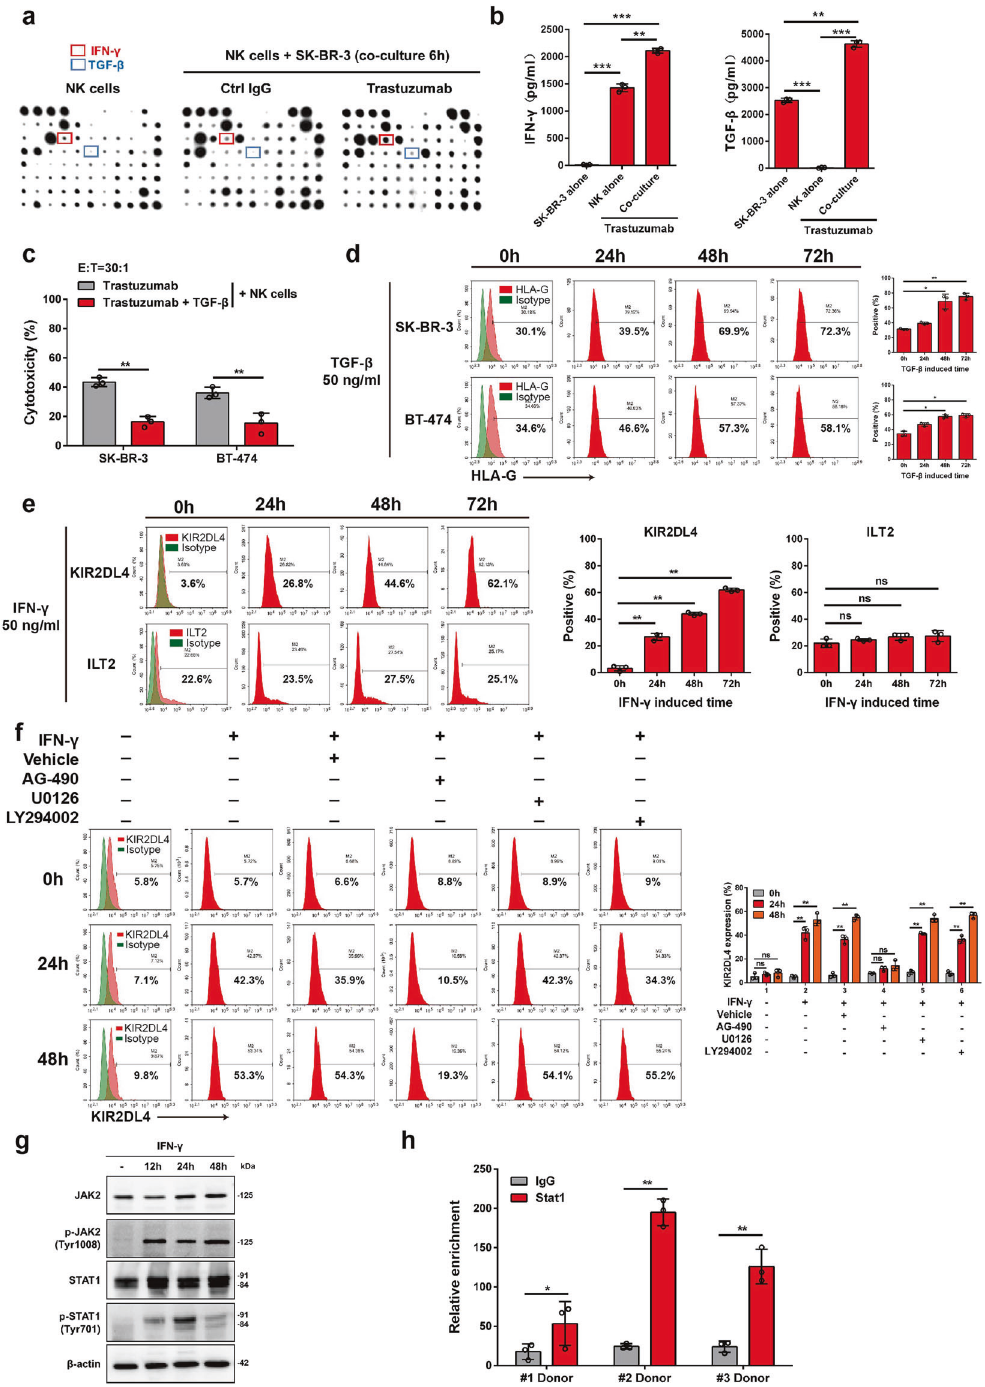
Fig. 4 TGF- β and IFN- γ upregulate HLA-G on breast cancer cells and KIR2DL4 on NK cells, respectively. a NK cells were cultured alone or with SK-BR-3 cells (E:T = 1:1) supplemented with the indicated antibodies. The supernatant was harvested and measured for cytokine levels using a cytokine antibody array. b NK cells and SK-BR-3 cells were cocultured or cultured alone for 48 h with or without trastuzumab, followed by measurement of IFN- γ and TGF- β production via ELISA. c FCM assay for determining the trastuzumab-elicited cytotoxicity of NK cells to cocultured HER2-positive breast cancer cells when treated with or without TGF- β (50 ng/ml) for 6 h. d Cells were incubated with TGF- β for the indicated times and were subjected to FCM assay for determining HLA-G level. e , f FCM assay for the expression of KIR2DL4 and ILT2 on NK cells incubated with IFN- γ and different inhibitors for the indicated times. g NK cells were incubated with IFN- γ (50 ng/ml) for the indicated times and were subjected to Western blot analysis. h ChIP assay for determining the enrichment of STAT1 on the KIR2DL4 promoter using